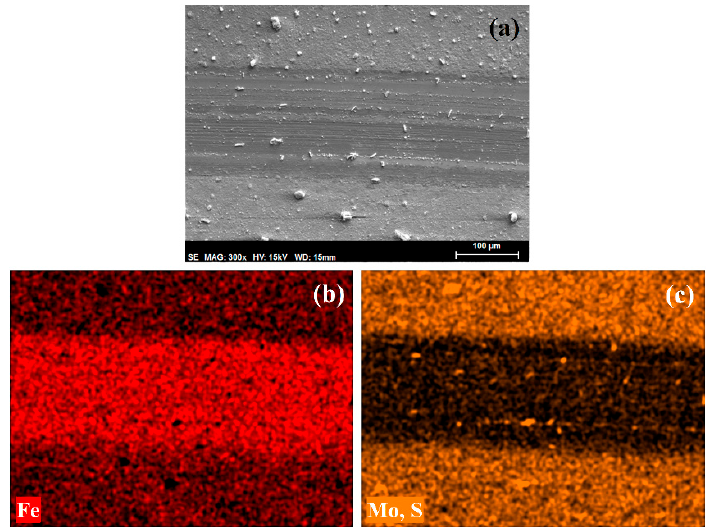
Figure 10. ( a ) SEM micrograph and ( b , c ) element maps of the wear track on AISI 316L disk after Figure 10 . ( a ) SEM micrograph and ( b – c ) element maps of the wear track on AISI 316L disk after lubrication with the dispersion of Mo 15 S 19 nanoparticles in linseed lubrication with the dispersion of Mo 15 S 19 nanoparticles in linseed oil.